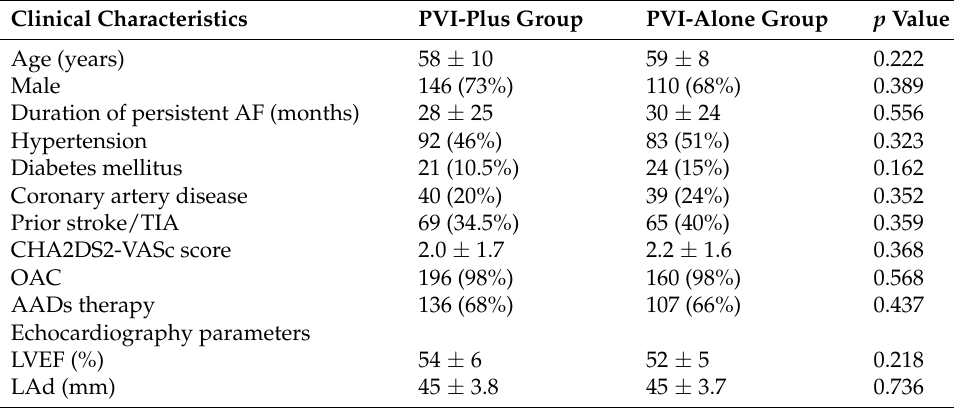
Table 1. The baseline characteristics of persistent AF patients.